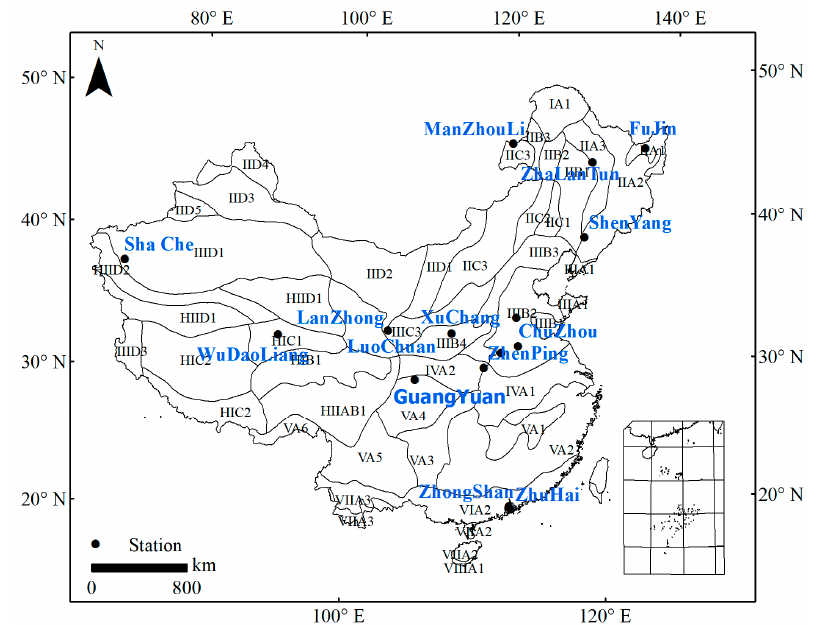
Figure 4. Map of the distribution of stations where the strongest and weakest ENSO causes drought lag time differences to occur.